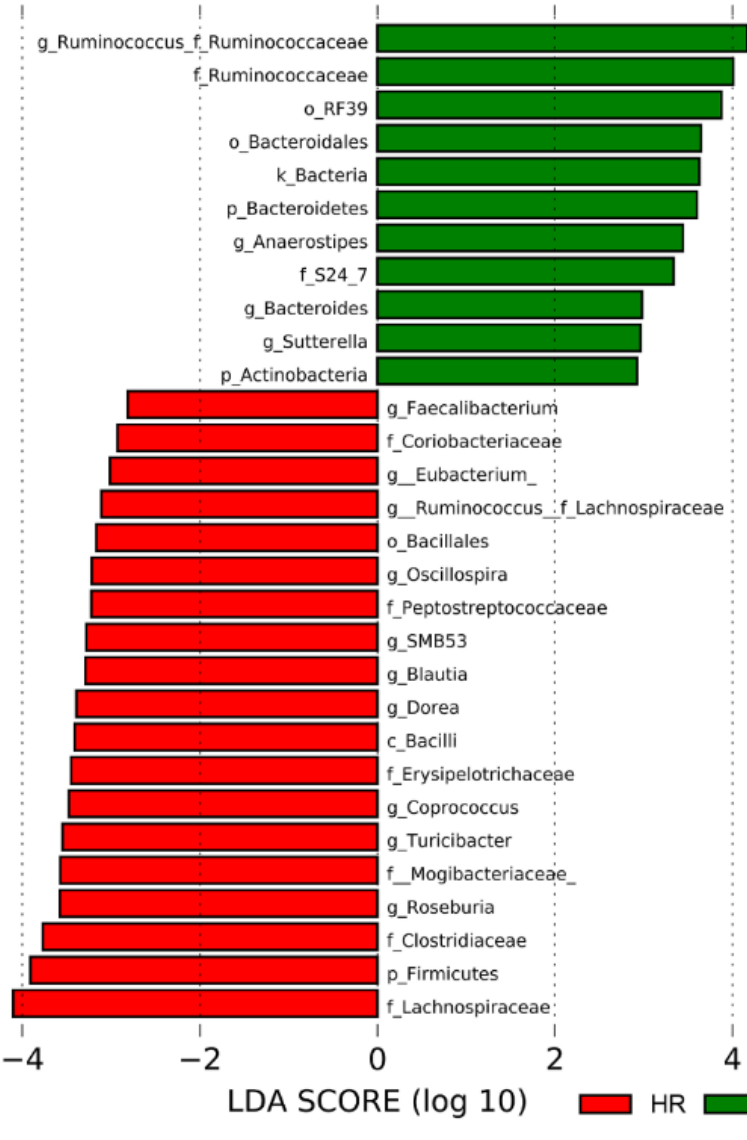
Figure 2. Linear discriminant analysis e ff ect size (LEfSe) plot describing the enriched taxa identified in each treatment group across all time points (HR, n = 45; LR, n = 41). The plot displays taxa with linear discriminant analysis (LDA) scores above 2.0 and p -values < 0.01. Abbreviations: g, genus; f, family; o, order; k, kingdom; p, phylum; c, class.